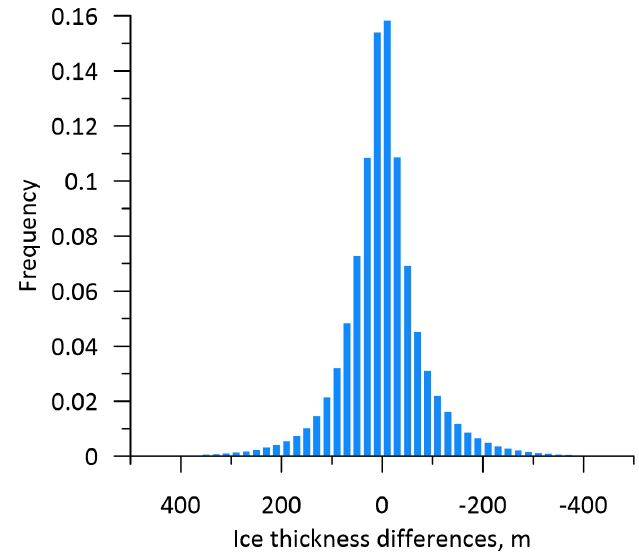
Figure 6. Histogram of difference between ice thickness grid and line RES data.